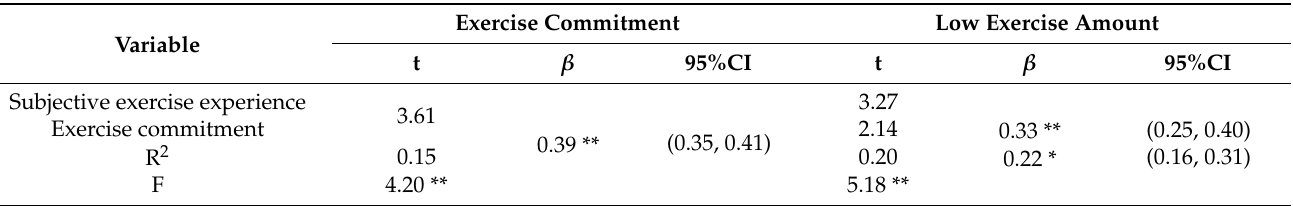
Table 6. The mediating effect of exercise commitment between the subjective exercise experience and low exercise